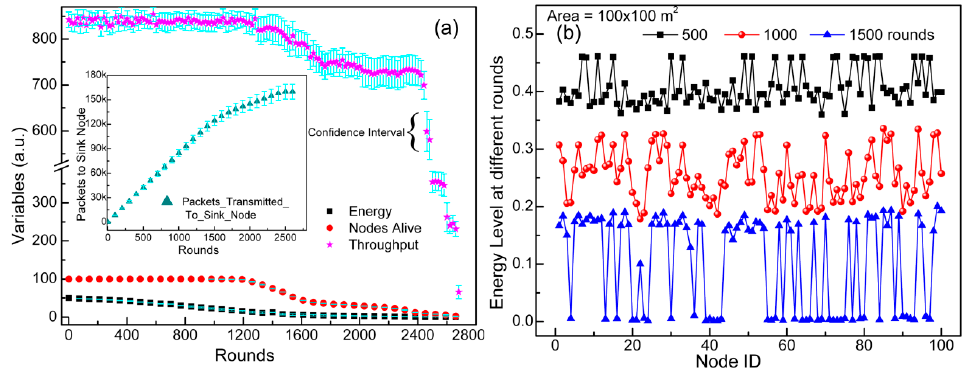
Figure 8. ( a ) 95% confidence interval of each point for all metrics of the MGBEHA protocol; and ( b )energy map of the whole topology at different rounds for the MGBEHA protocol.